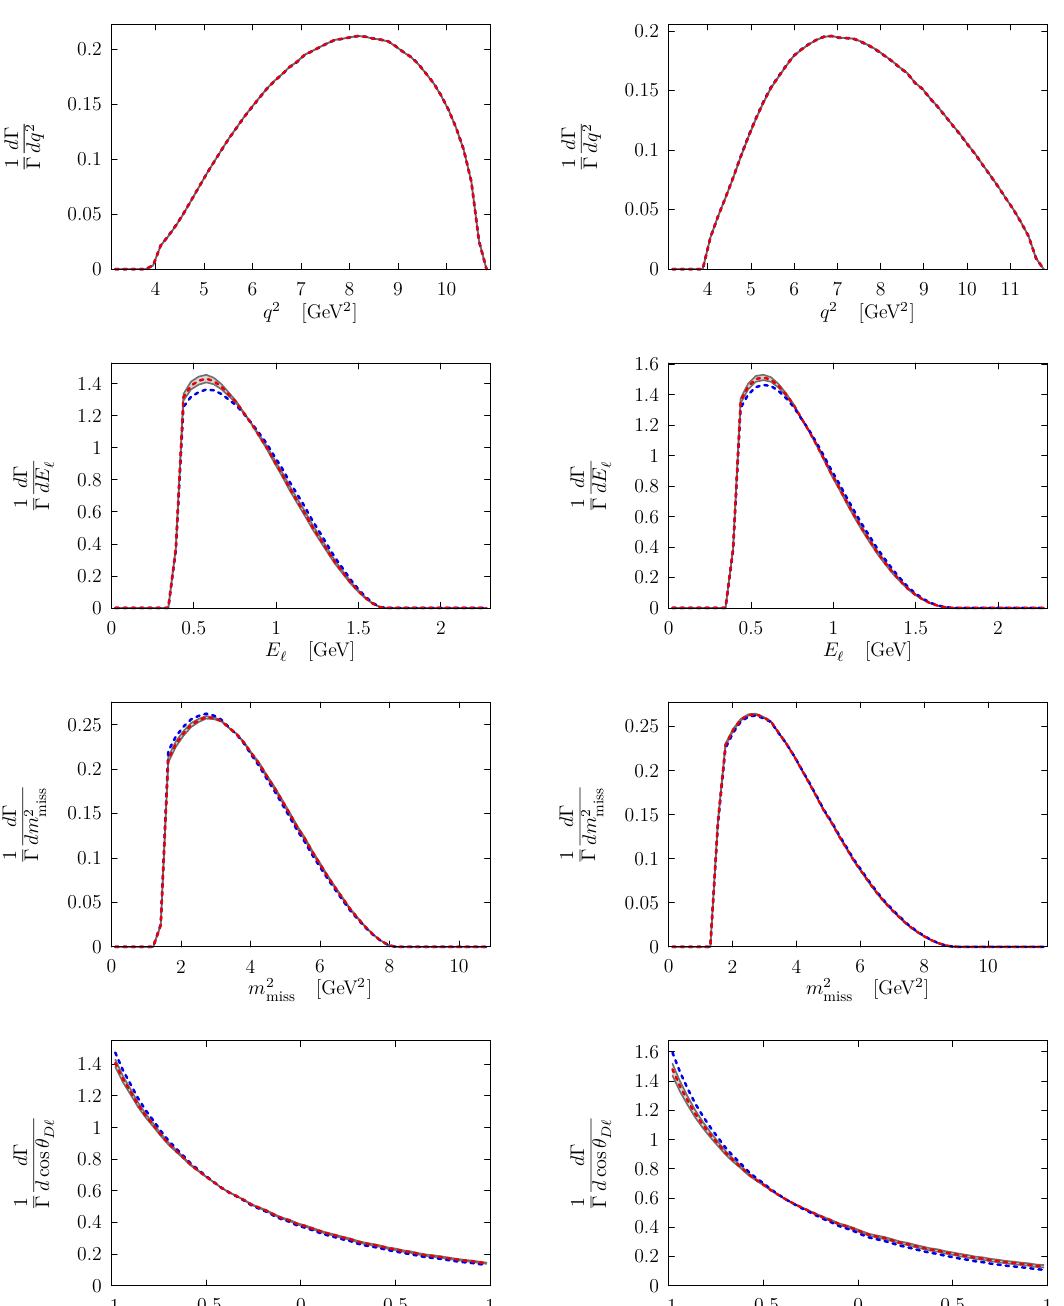
Figure 2 . Kinematic distributions in the B rest frame for C 23 ; 3 2 [0 : 26 ; 0 : 66] (gray regions) with phase space cuts (2.9), for B ! ( D (cid:3) ! D(cid:25) )( (cid:28) ! ‘ (cid:22) (cid:23) ‘ (cid:23) (cid:28) )(cid:22) (cid:23) (left) and B ! D ( (cid:28) ! ‘ (cid:22) (cid:23) ‘ (cid:23) (cid:28) )(cid:22) (cid:23) (right). The blue (red) dashed curves show the SM (SM+ W 0 best (cid:12)t: C 23 ; 3 = 0 : 46, m N